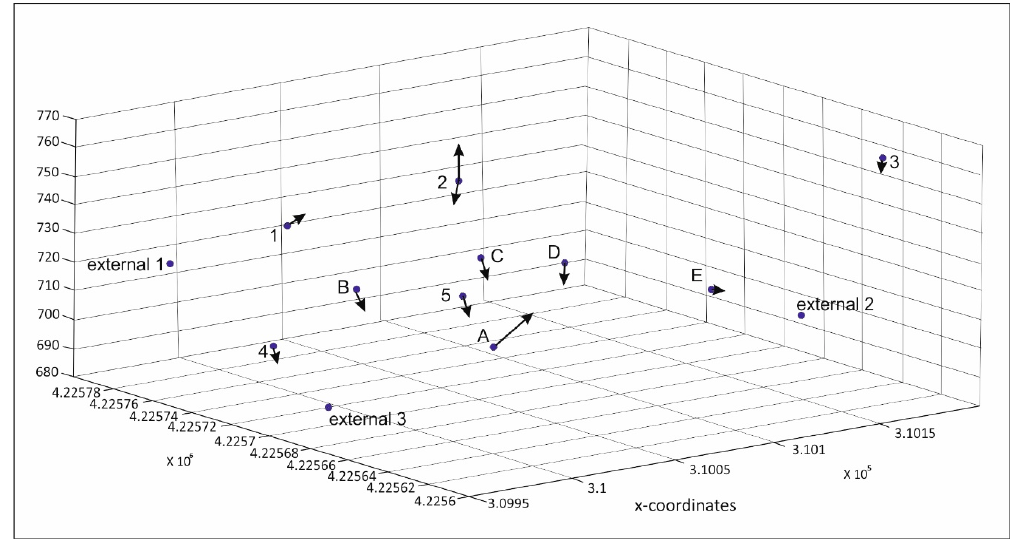
Figure 6. The results of the repeated GNSS measurements as displayed in a vector format in a three-axis diagram.